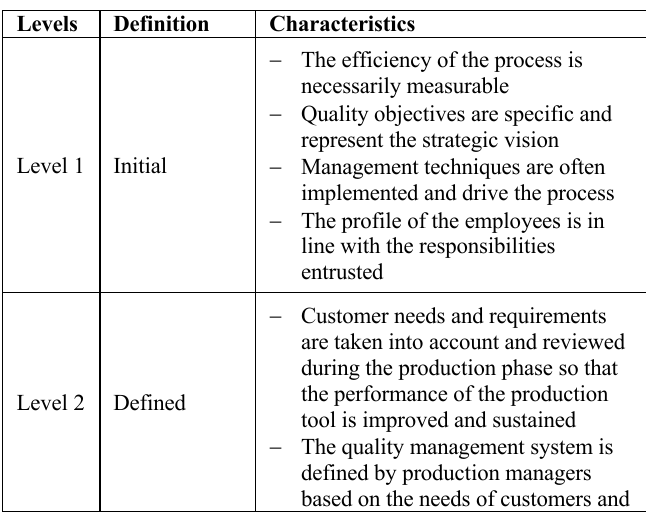
Table 1. Characteristics of the process of performance management system in function of maturity